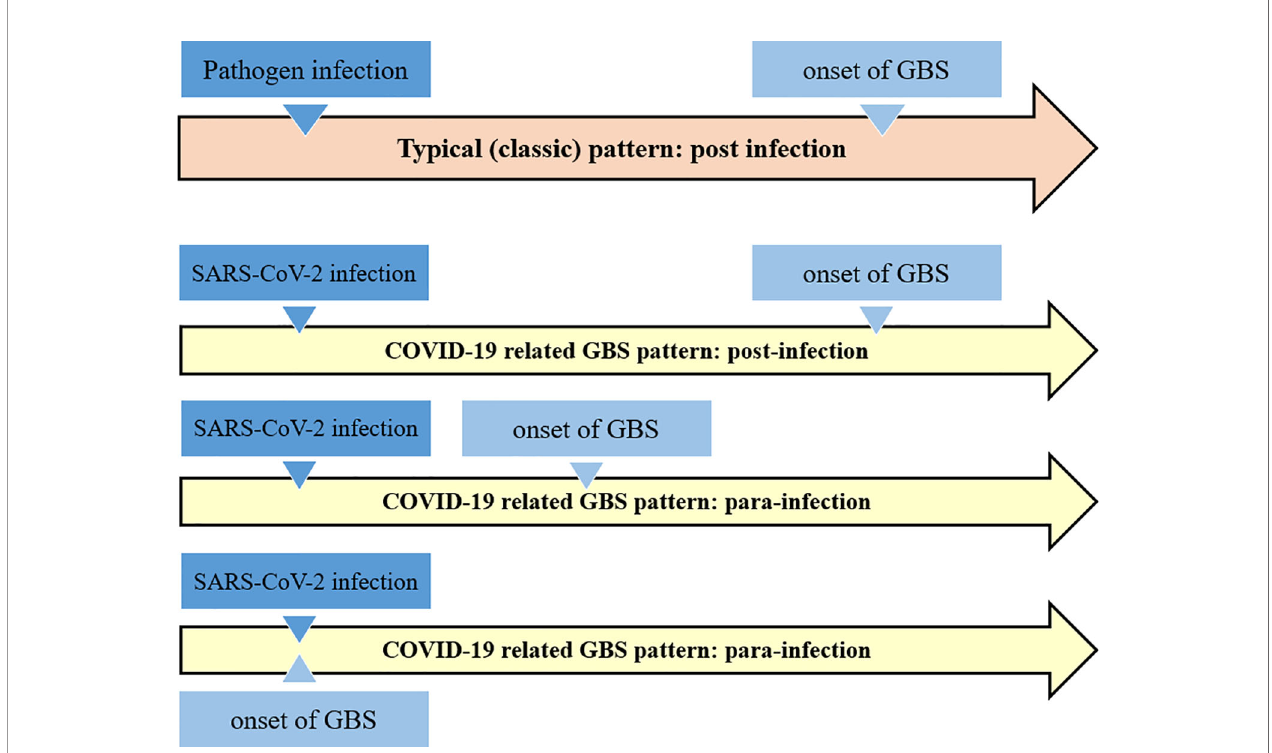
FIGURE 2 | Schematic comparison of the classical Guillain-Barre ́ syndrome pattern with the COVID-19 related GBS. It appears that COVID-19 related GBS follow the both post- and para-infections